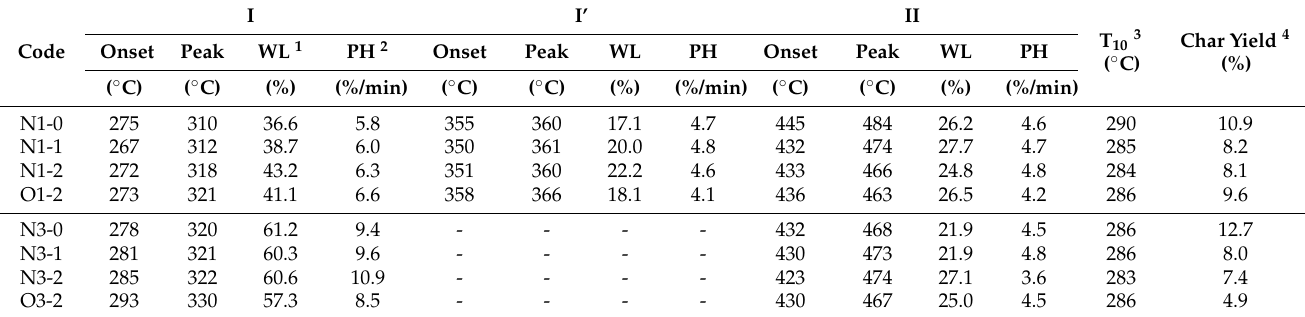
Figure 9. TGA ( A , B ) and DTG ( C , D ) curves for PU foams. Table 4. Thermal parameters of PU foams.